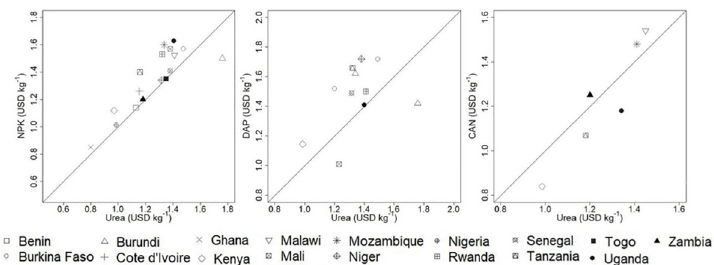
Fig 2. NPK median price (USD kg -1 ) versus urea median price (USD kg -1 ); DAP median price (USD kg -1 ) versus urea median price (USD kg -1 ); CAN median price (USD kg -1 ) versus urea median price (USD kg -1 ) for each country and location where both prices were reported. All the prices are non-subsidized. The black line represents y = x